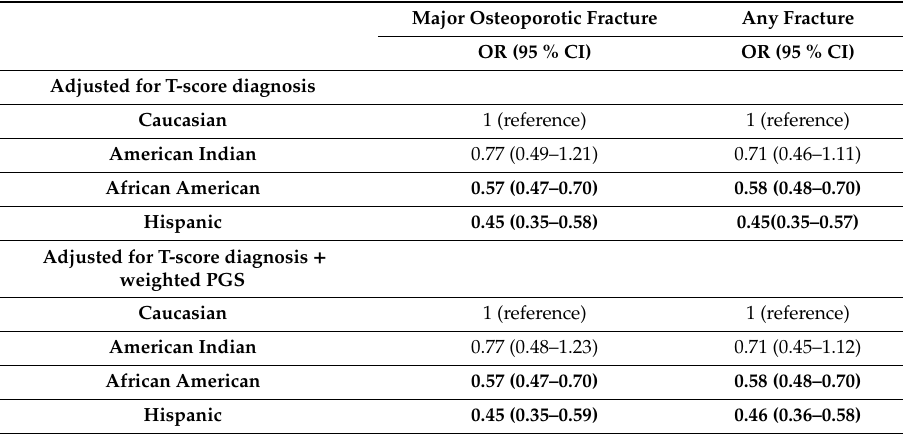
Table A4. Hazard Ratios (HR) with 95% Confidence Interval (CI) for Outcomes of Incidence Fracture According to Race Group, adjusted for T-score diagnosis: Results from Cox Proportional Hazard Model, Individuals with Previous Fractures were Excluded.